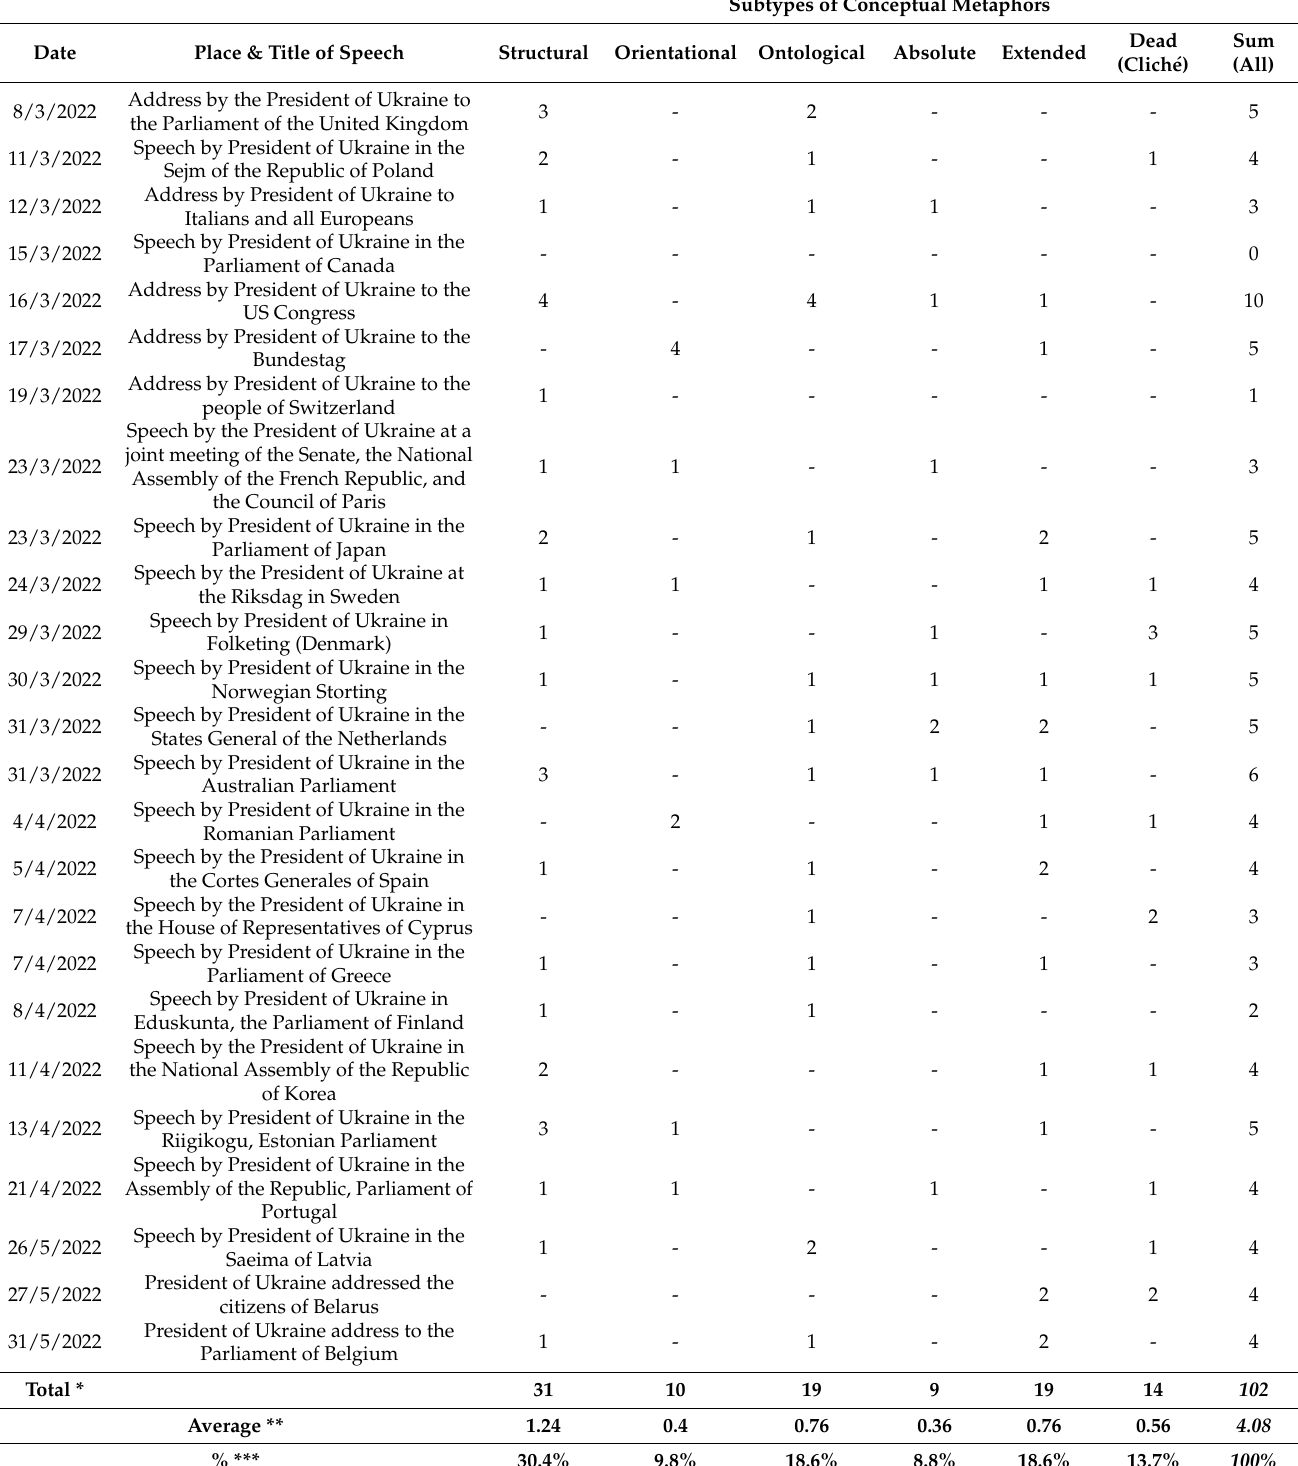
Table 5. Utilization of Metaphors by the Ukraine President in his Addresses: Analysis per Subtype, based on the Conceptual Metaphors